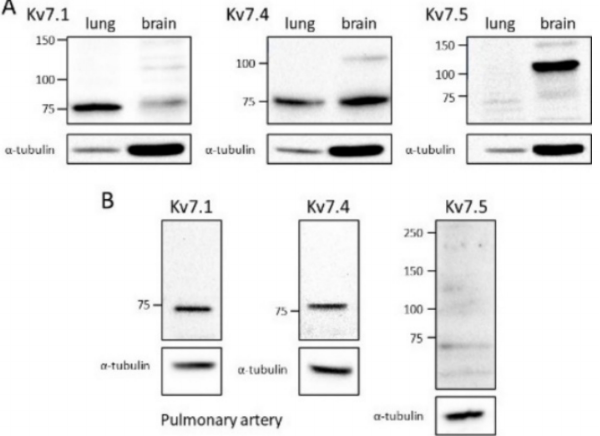
Figure 7. Kv7 channel protein expression in rat pulmonary arteries. Immunoblots of Kv7 channel α -subunit and α -tubulin proteins, using lysates isolated from whole rat lung or brain ( A ) or isolated rat pulmonary arteries ( B ). Each blot is typical of experiments repeated on tissues from at least 4 rats. Wells were injected with lysate containing 25 µ g of protein. Numbers to the left of each blot indicate the positions of molecular weight markers (kDa). Each gel was cut to stain separately for α -tubulin (50 kD), used as a loading